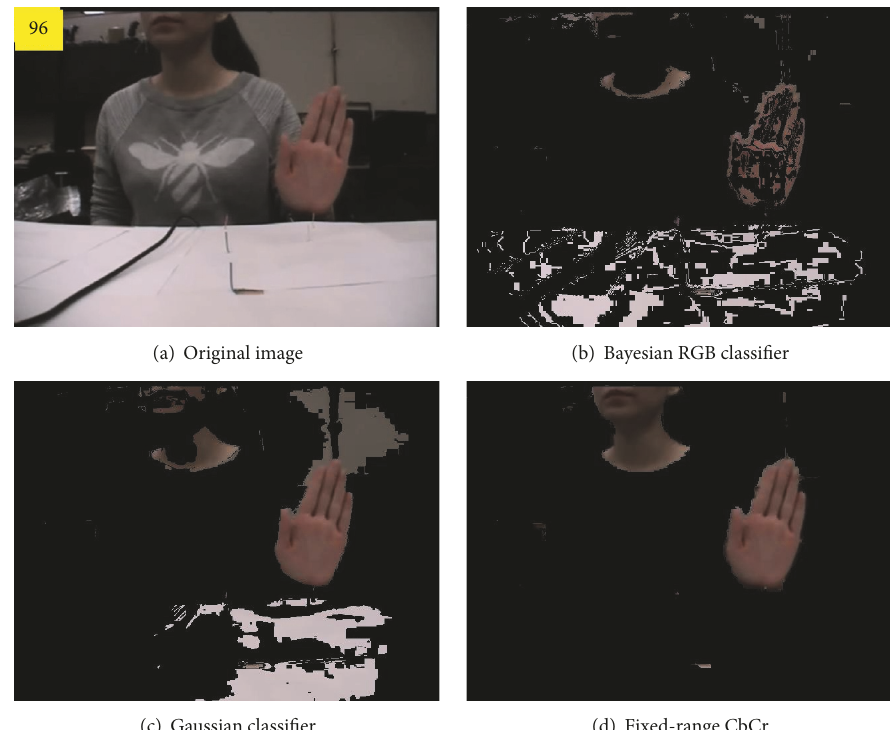
Figure 5: Hand segmentation by different skin classifier.